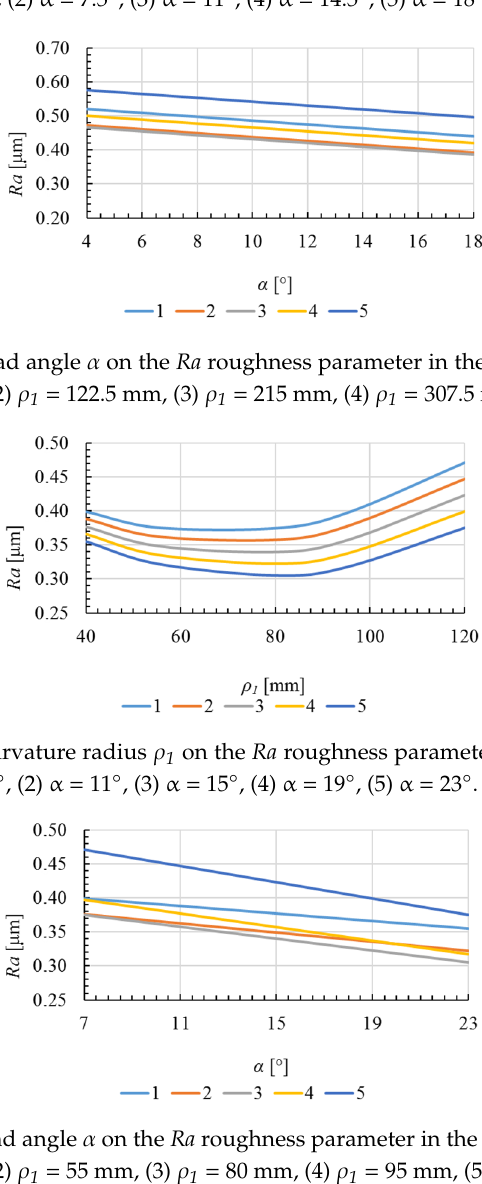
Figure 14. Effect of the lead angle α on the Ra roughness parameter in the machining of the concave surface: (1) ρ 1 = 40 mm, (2) ρ 1 = 55 mm, (3) ρ 1 = 80 mm, (4) ρ 1 = 95 mm, (5) ρ 1 = 120 mm.